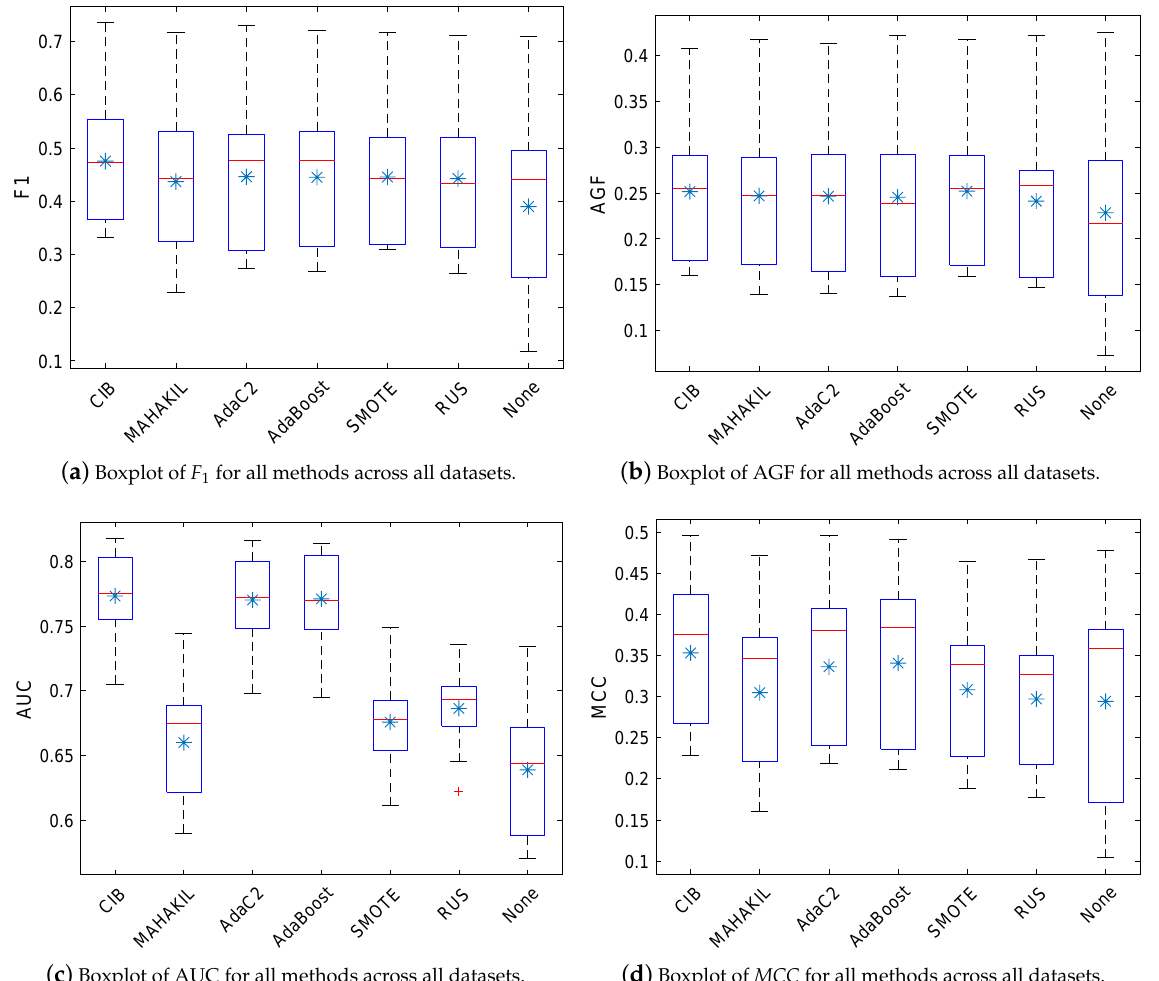
( c ) Boxplot of AUC for all methods across all datasets. ( d ) Boxplot of MCC for all methods across all datasets. Figure 3. Boxplot of F 1 , AGF, AUC, and MCC across all PROMISE datasets for our CIB and the baselines. The horizontal line in the box denotes median and the asterisk indicates mean